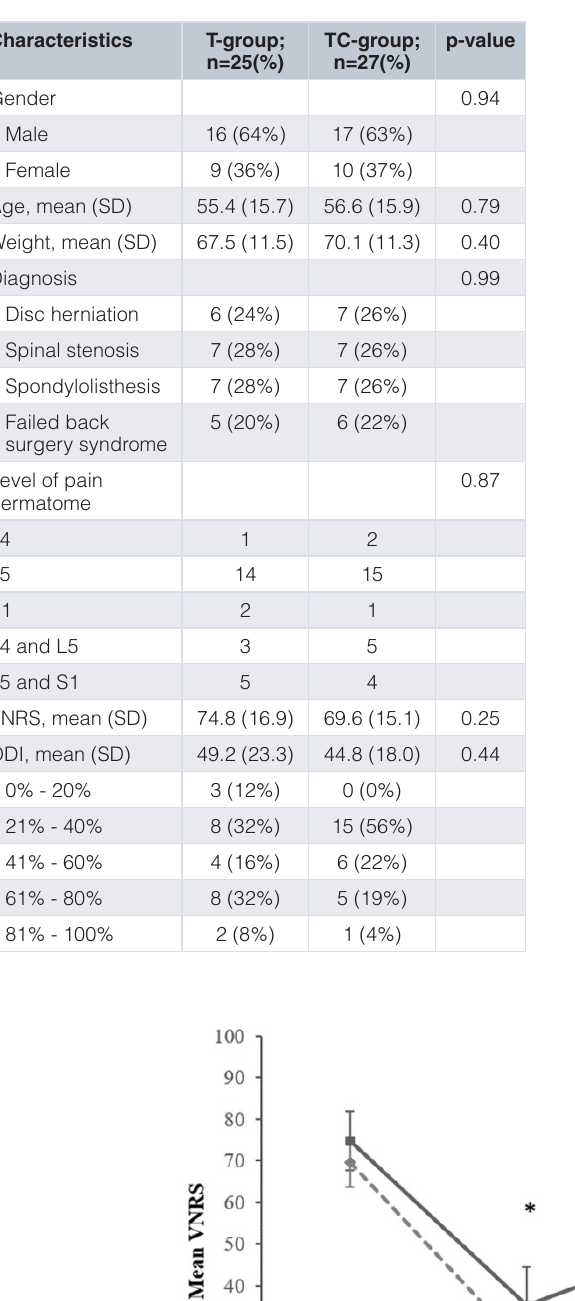
Table 1. Patient characteristics at baseline.